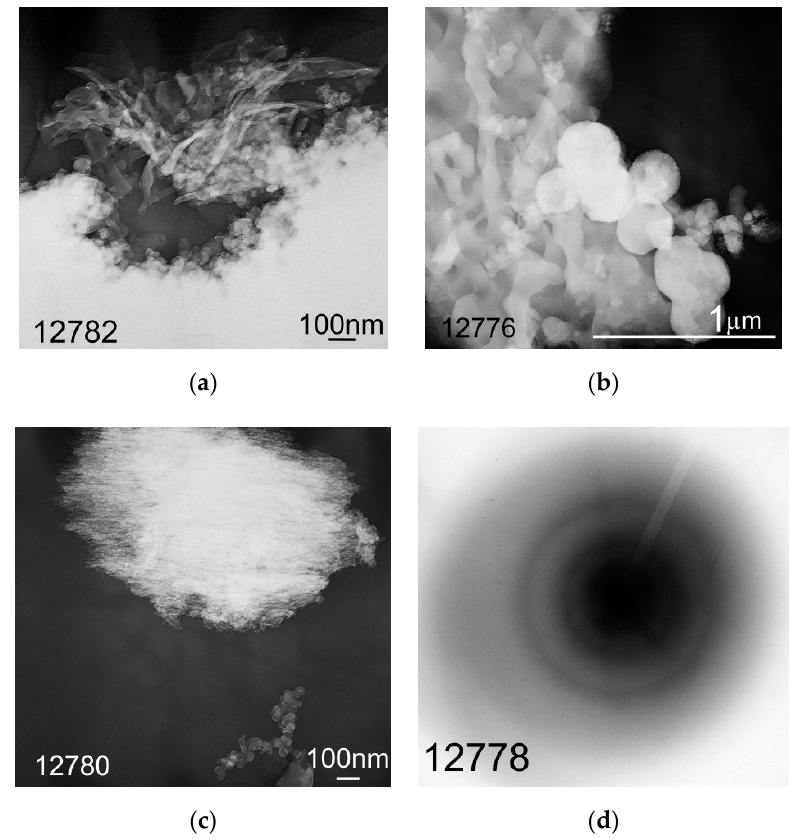
Figure 7. Morphology of rice husk hydrolytic lignin carbonization products presented by different forms particles: ( a ) fibers/tapes; ( b ) fibers and spherical particles; ( c ) isomorphic and dendritic formations; ( d ) microdiffraction pattern of carbon rounded particles. Table 4. Parameters of EPR spectra of rice husk hydrolytic lignin and its carbonization products.